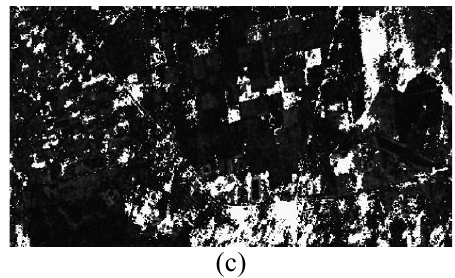
Figure 2: Test statistic output on different cases. (a) Only VV channel (b) Only diagonal elements of C3 (c) Using full